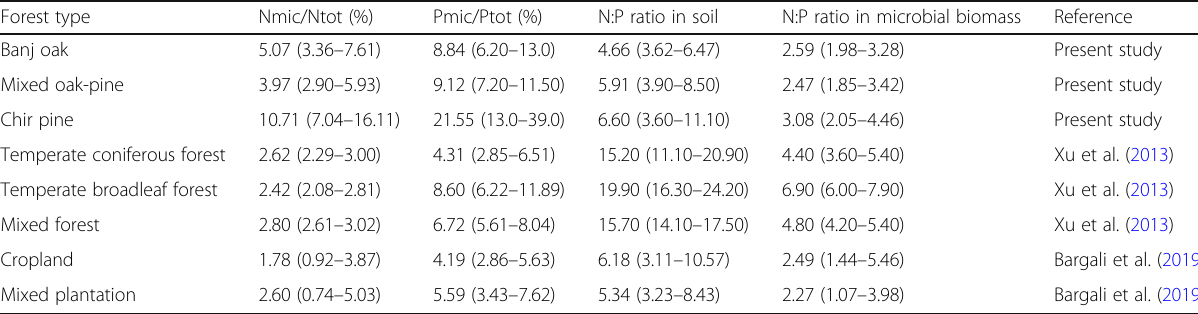
Table 2 Summarized percentage of soil elements contained in soil microbial biomass Forest type